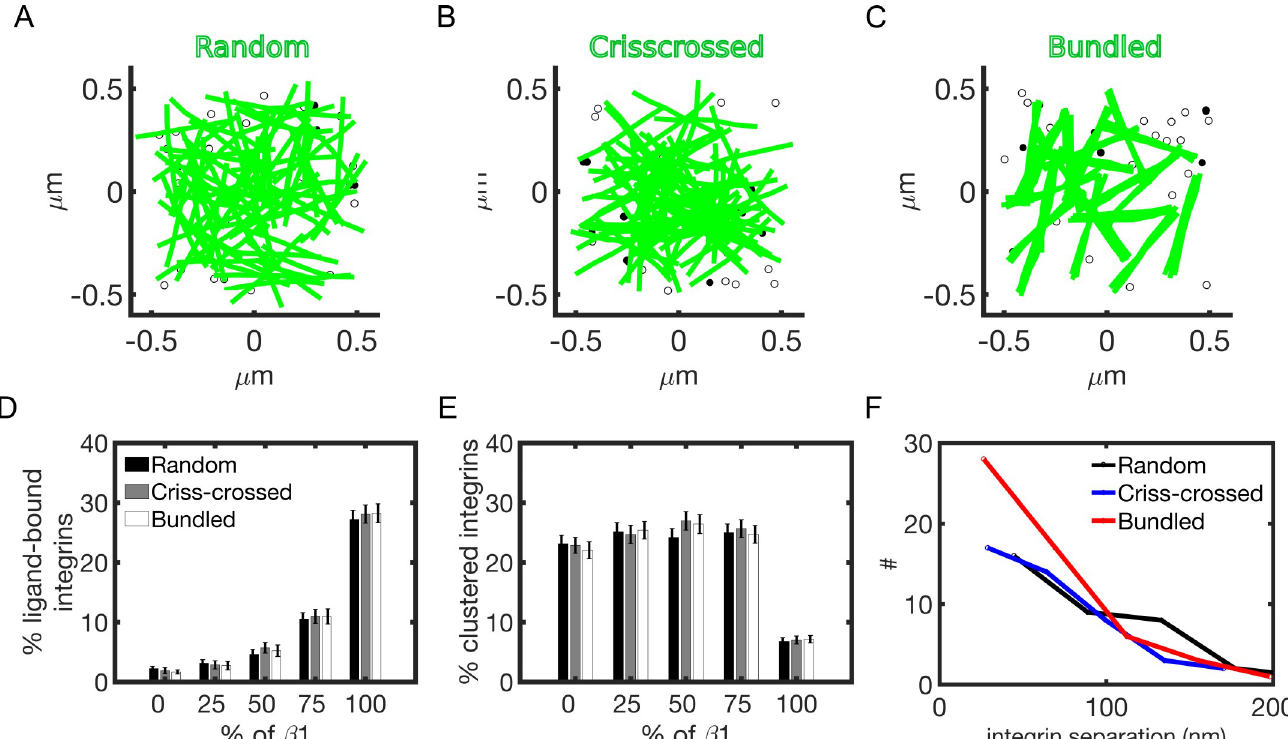
Fig 6. Actin architecture does not impact integrin clustering and ligand binding but changes the physical distribution of integrins in adhesions. (A-C) Snapshots from the simulations: random, crisscrossed and bundled actin networks above a layer of integrins. Filled circles indicate clustered integrins; empty circles indicate ligand-bound integrins. (D) Average percentage of ligand-bound integrins with respect to increasing amount of β -1 integrins (using E varying actin architectures. (E) Corresponding percentage of clustered integrins. (F) Distribution of average nearest neighbor distances between ligand-bound integrins using 50% β -1 integrins at varying actin architectures. Results are computed as averages between 20–30 s of simulation.